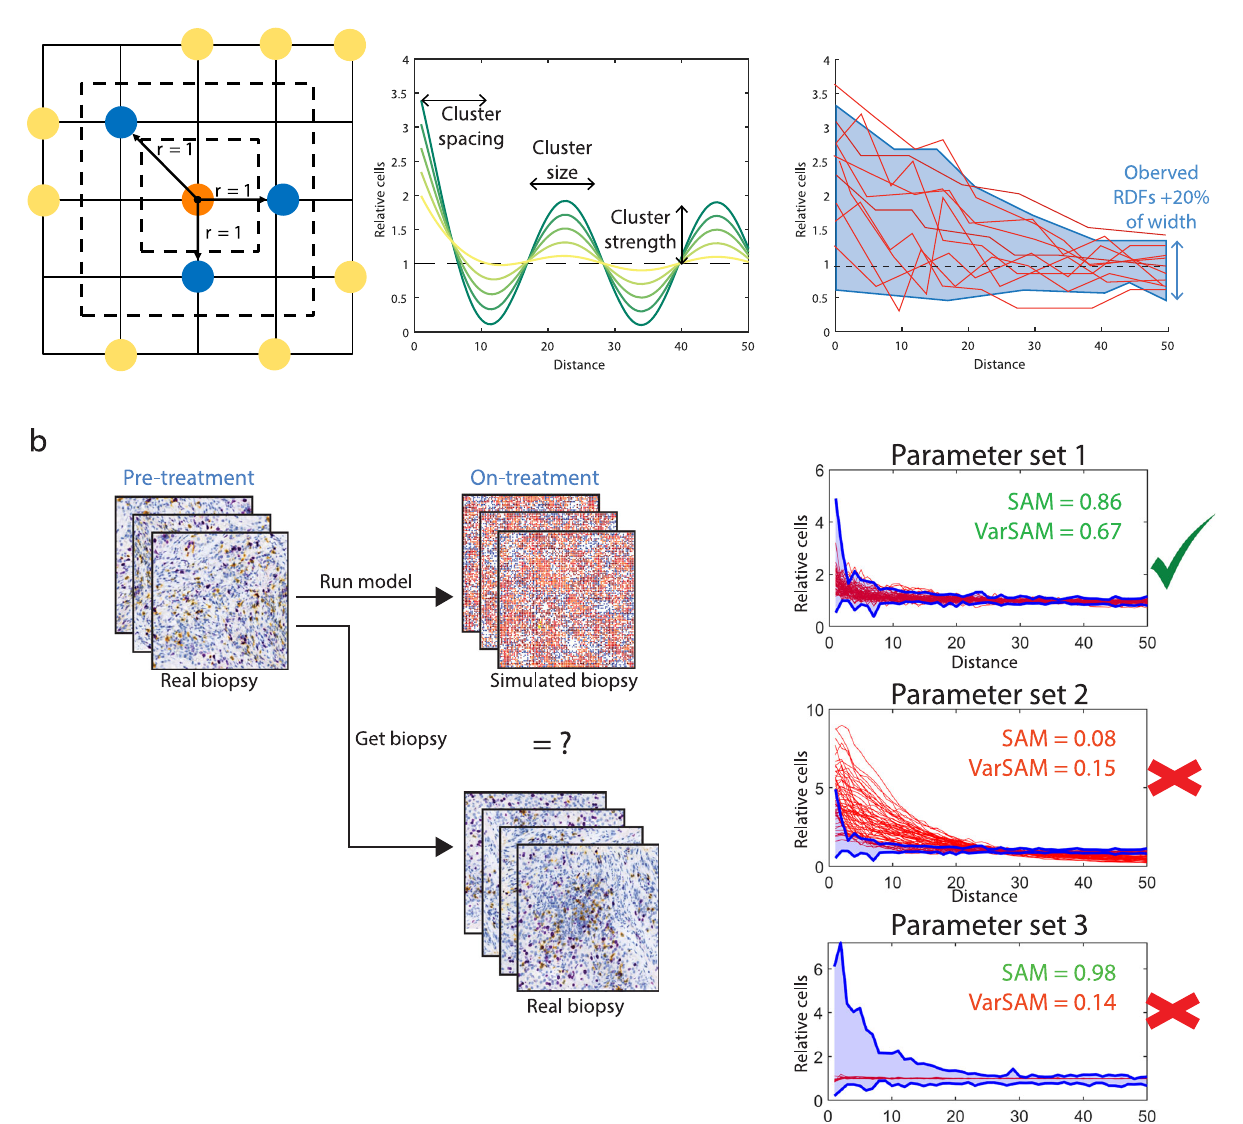
Fig. 2 Development of a spatial agreement measure (SAM) for model optimisation and validation. a The radial distribution function calculated on a grid is illustrated on the left. From each cell, the Chebyshev distance to every other cell is computed and a histogram is obtained for the total number of cells at each radius. The values are normalised by the mean density of cells on the entire tile. The radial distribution function is plotted as a function of distance as shown in the middle. The characteristics of the radial distribution function correspond to spatial features as indicated. To compare the groups of radial distribution functions on simulated and observed tiles, the SAM is calculated. b A conceptual outline of the SAM with examples of accepted and rejected simulations with their respective SAM and VarSAM